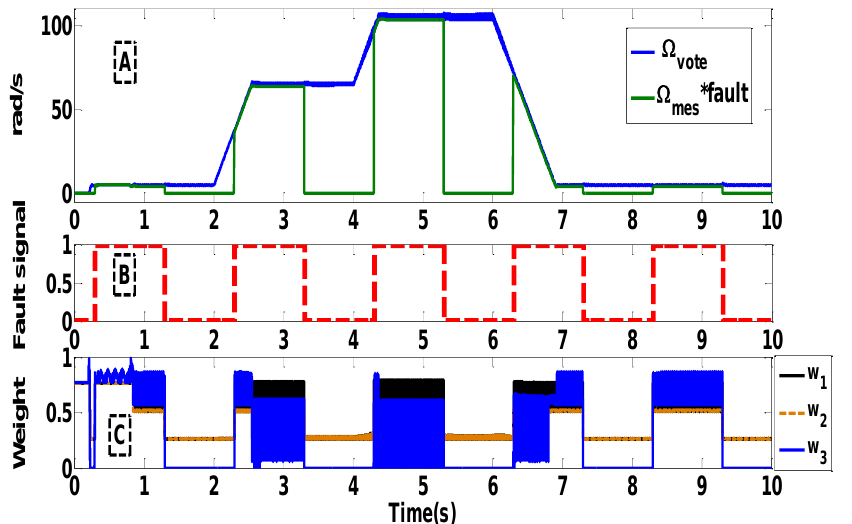
Figure 19. ( A ) The output of the fuzzy voting algorithm, ( B ) The applied fault signal, ( C ) The weights of the fuzzy voter.